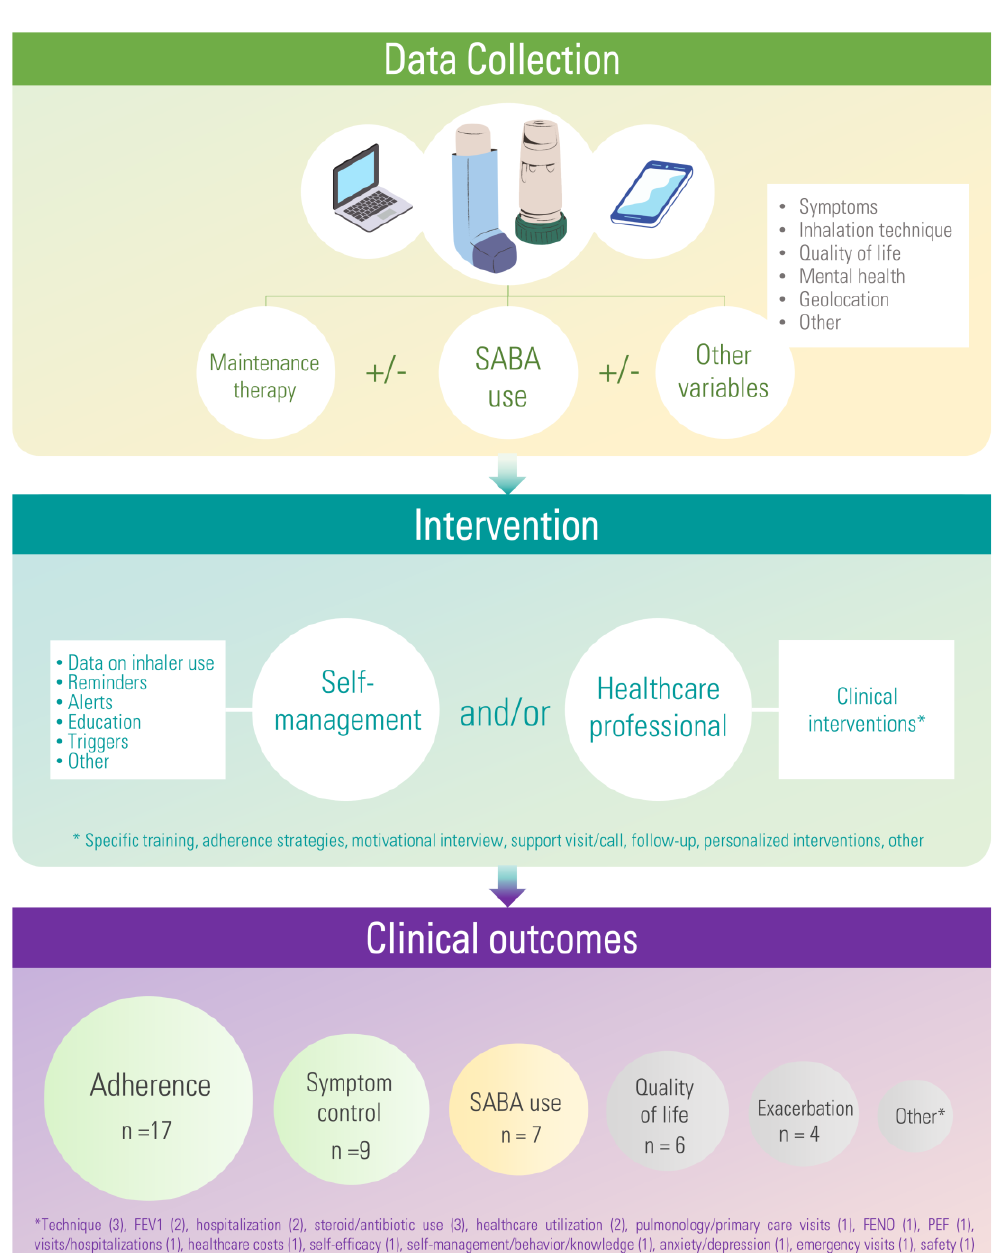
Figure 3. Visual summary of results. Colour guide in the clinical outcomes section: green (positive effects in some studies, confirmed in the meta–analysis); yellow (positive effects in some studies, meta–analysis not performed); and grey (mixed or no effects with the data available). Acronyms: n (number of studies assessing a specific outcome); SABA (short-acting beta agonist).